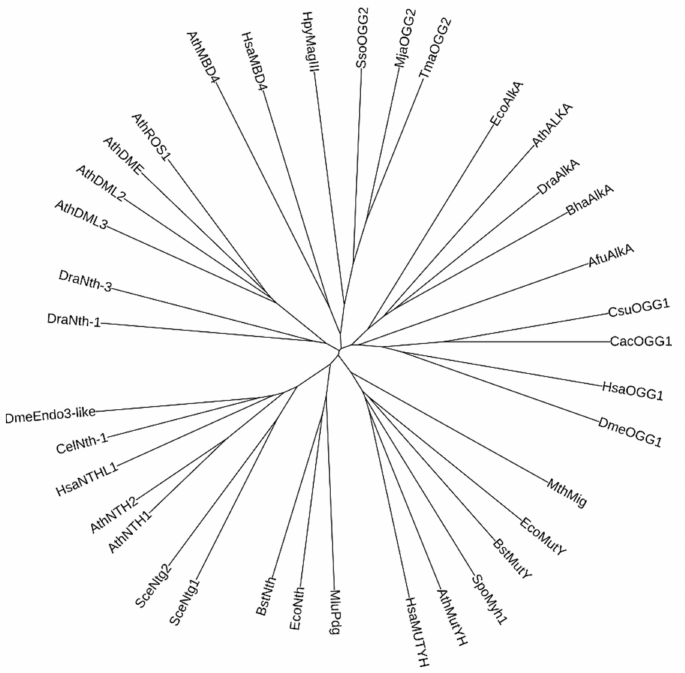
Figure 6. Unrooted tree of selected HhH DNA glycosylases. The species are: Afu, Archaeoglobus fulgidus ; Ath, Arabidopsis thaliana ; Bha, Alkalihalobacillus (formerly Bacillus ) halodurans ; Bst, Geobacillus (formerly Bacillus ) stearothermophilus ; Cac, Clostridium acetobutylicum ; Cel, Caernorhabditis elegans ; Csu, Caldanaerobacter subterraneus (formerly Thermoanaerobacter tengcongensis ); Dme, Drosophila melanogaster ; Dra, Deinococcus radiodurans ; Eco, Escherichia coli ; Hpy, Helicobacter pylori ; Hsa, Homo sapiens ; Mja, Methanocaldococcus jannaschii ; Mlu, Micrococcus luteus ; Mth, Methanothermobacter thermautotrophicus (formerly Methanobacterium thermoformicicum ); Sce, Saccaromyces cerevisiae ; Spo, Schizosaccharomyces pombe ; Sso, Saccharolobus (Sulfolobus) solfataricus ; Tma, Thermotoga maritima . The selected proteins are HhH DNA glycosylases characterized either biochemically or structurally. The phylogenetic tree was produced by Clustal Omega [124] and visualized using iTOL